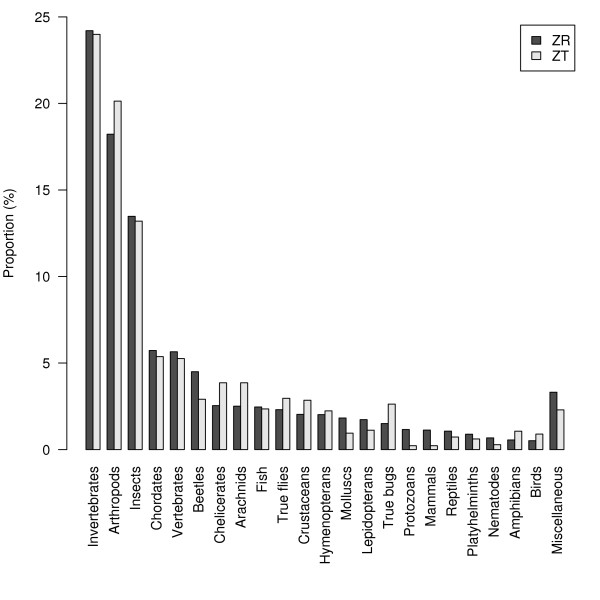
Comparison of the proportion of taxa studied in all works publishing new species in 2006 and indexed in the Zoological Record (ZR, 5620 articles) and in the Zootaxa subset (ZT, 743 articles). Search query: expression "sp nov" from ZR thesaurus AND "2006".